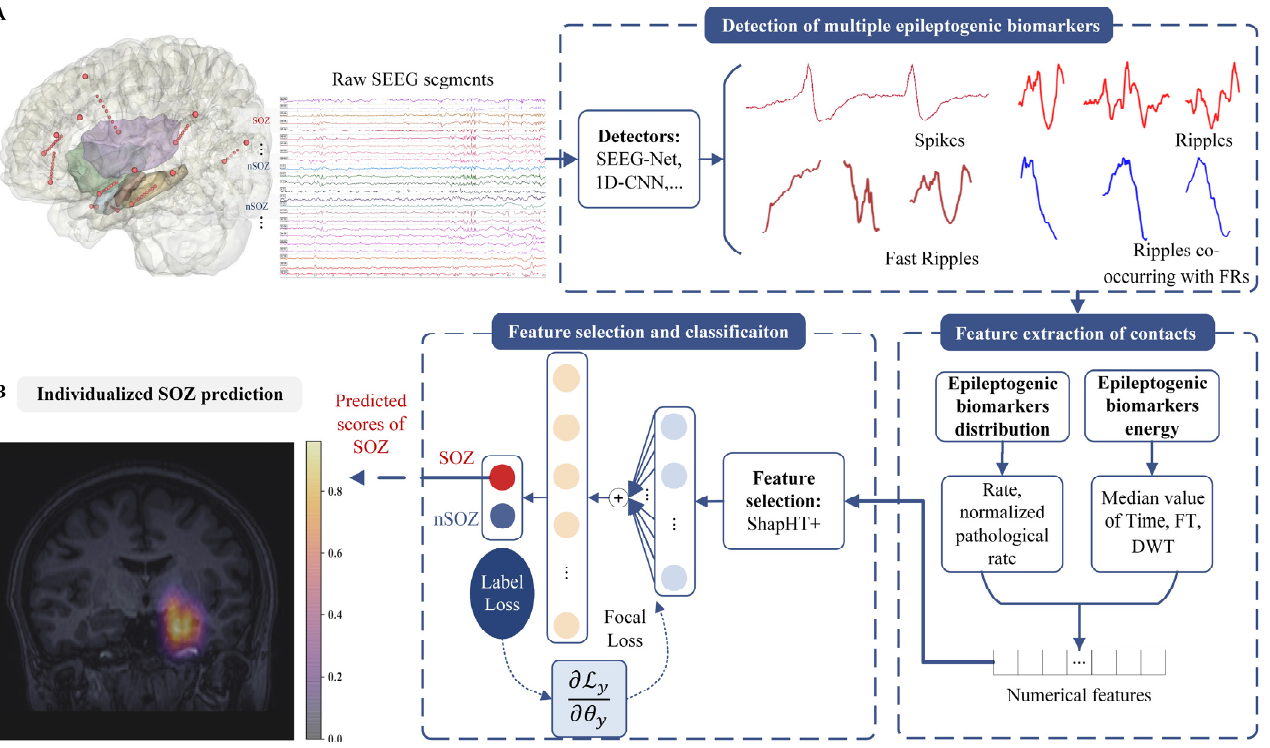
Figure 2. The pipeline of SOZ localization method: MEBM-SC: ( A ) the work scheme contains SEEG recording, multiple epileptogenic biomarkers detection, contact features’ extraction, feature selection and contact’s classification; and ( B ) interpolation of prediction scores onto patient’s individual MRI. Note: SOZ, seizure onset zone; nSOZ, non-seizure onset zone; FRs, fast ripples; FT, fourier transform; DWT, discrete wavelet transformation.